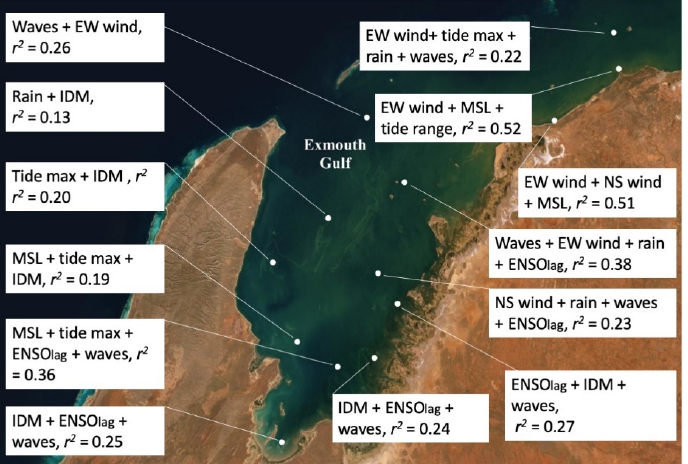
Figure 8. Multiple regression results showing the metocean processes, east–west (EW) winds, north–south (NS) winds, mean sea level (MSL), tidal maxima, tidal range, rainfall, ENSO (10-month phase lag), wave power and Indian Ocean Diploe Mode (IDM), that best described turbidity at 13 locations in the Exmouth Gulf region between 2002 and 2019. Models were chosen by a backward stepwise regression process where the least significant variable was removed at each step and the best model chosen using the Akaike Information Criterion (AIC). Full regression table results available in Appendix A. Table 1. Pearson’s R correlation coefficients for ( a ) turbidity and environmental variables (wave power, east–west winds, north–south winds, tidal range (monthly average), tidal range (3-day average), tidal maximum, mean sea level, rainfall, Indian Ocean Dipole Mode (IDM) and El Niño–Southern Oscillation (ENSO) in the Exmouth Gulf. All correlations are from monthly averaged values except for 3-day tidal range. The R 2 value was derived from multiple regression models using all variables (full stepwise regression table results in Appendix A); ( b ) correlations between waves and other environmental variables at 13 locations in the Exmouth Gulf and ( c ) correlations between all the environmental variables except waves. (a) Correlation (Pearson’s r) between turbidity and metocean processes at each